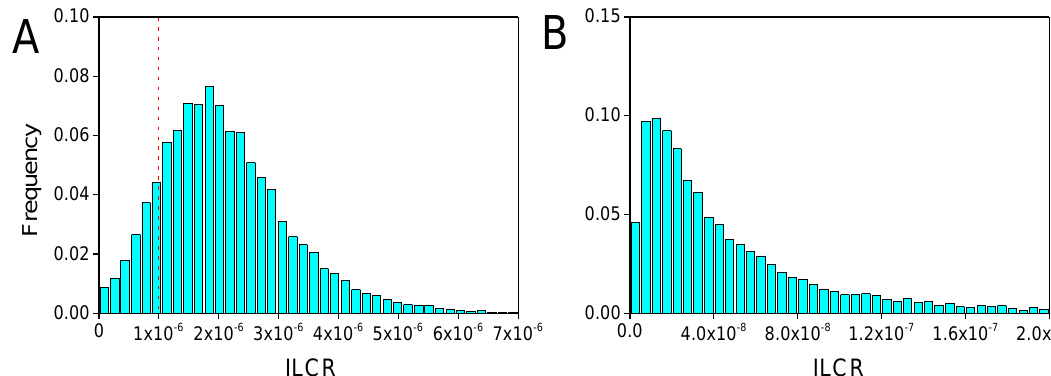
Figure 6. Distributions of incremental lifetime cancer risk for children, derived using Monte Carlo simulations in the heating season ( A ) and the non-heating season ( B ). Red lines represent the U.S. Environmental Protection Agency acceptable risk level.